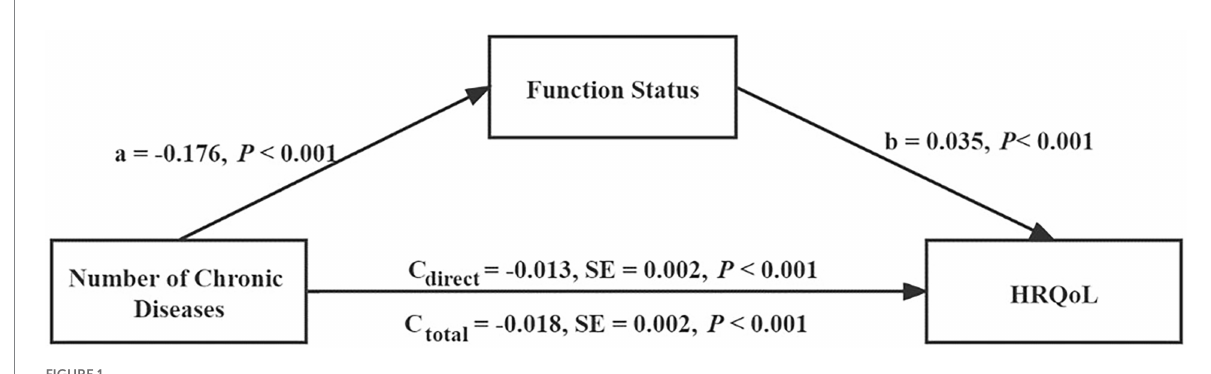
FIGURE 1 Regression coefficient was derived from a mediation model that was adjusted for age, gender, education, marital status, smoking, and drinking status ( n = 2,887).